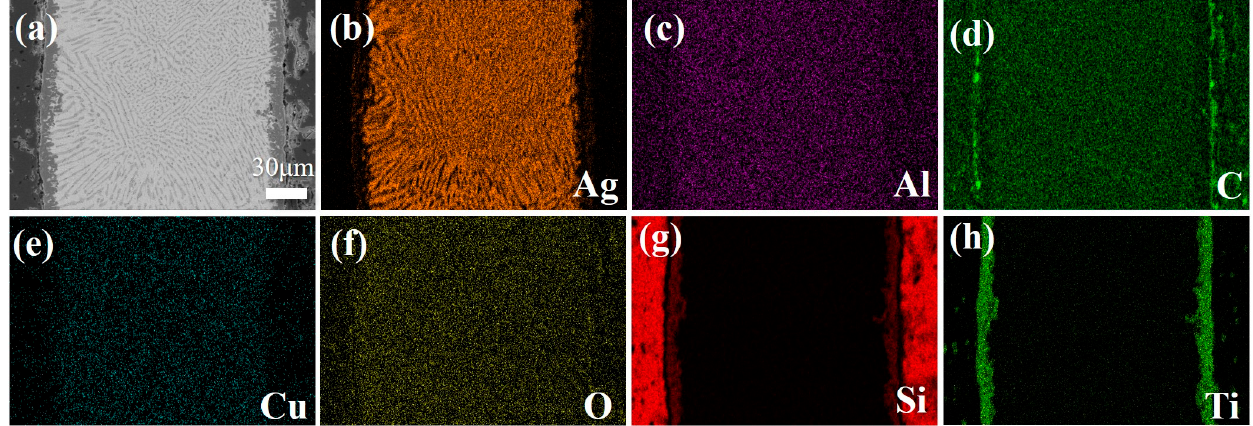
Figure 5. Microstructure and elemental distribution of SiC/AgCuTi + 1 wt% LAS/SiC joint brazed at 900 °C for 10 min ( a ) microstructure of joint, and ( b – h ) elemental distributions.